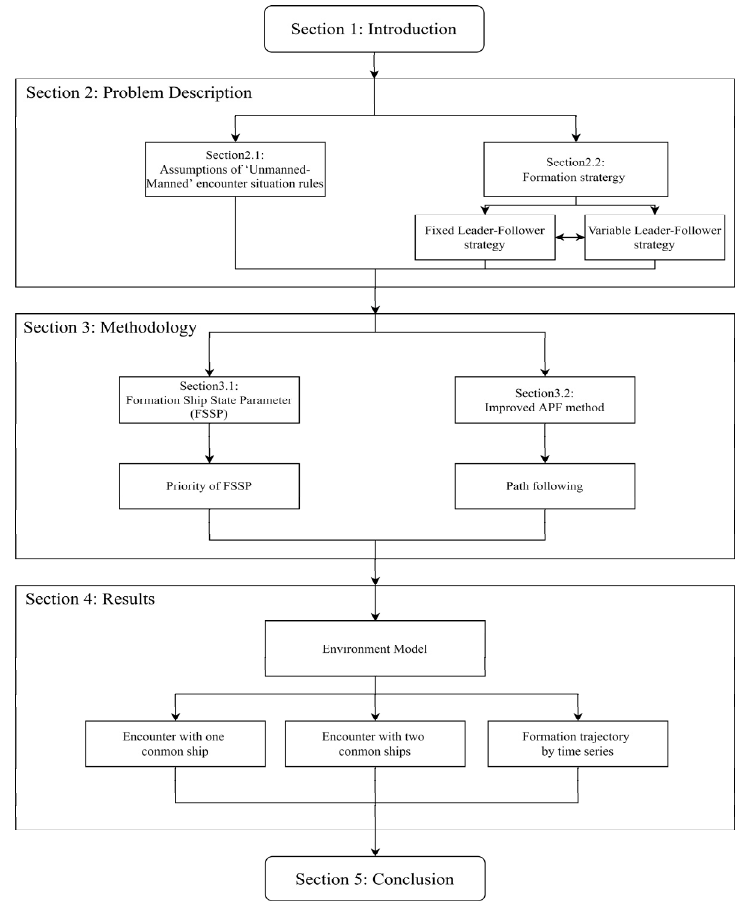
Figure 2. Section structure diagram of this paper.